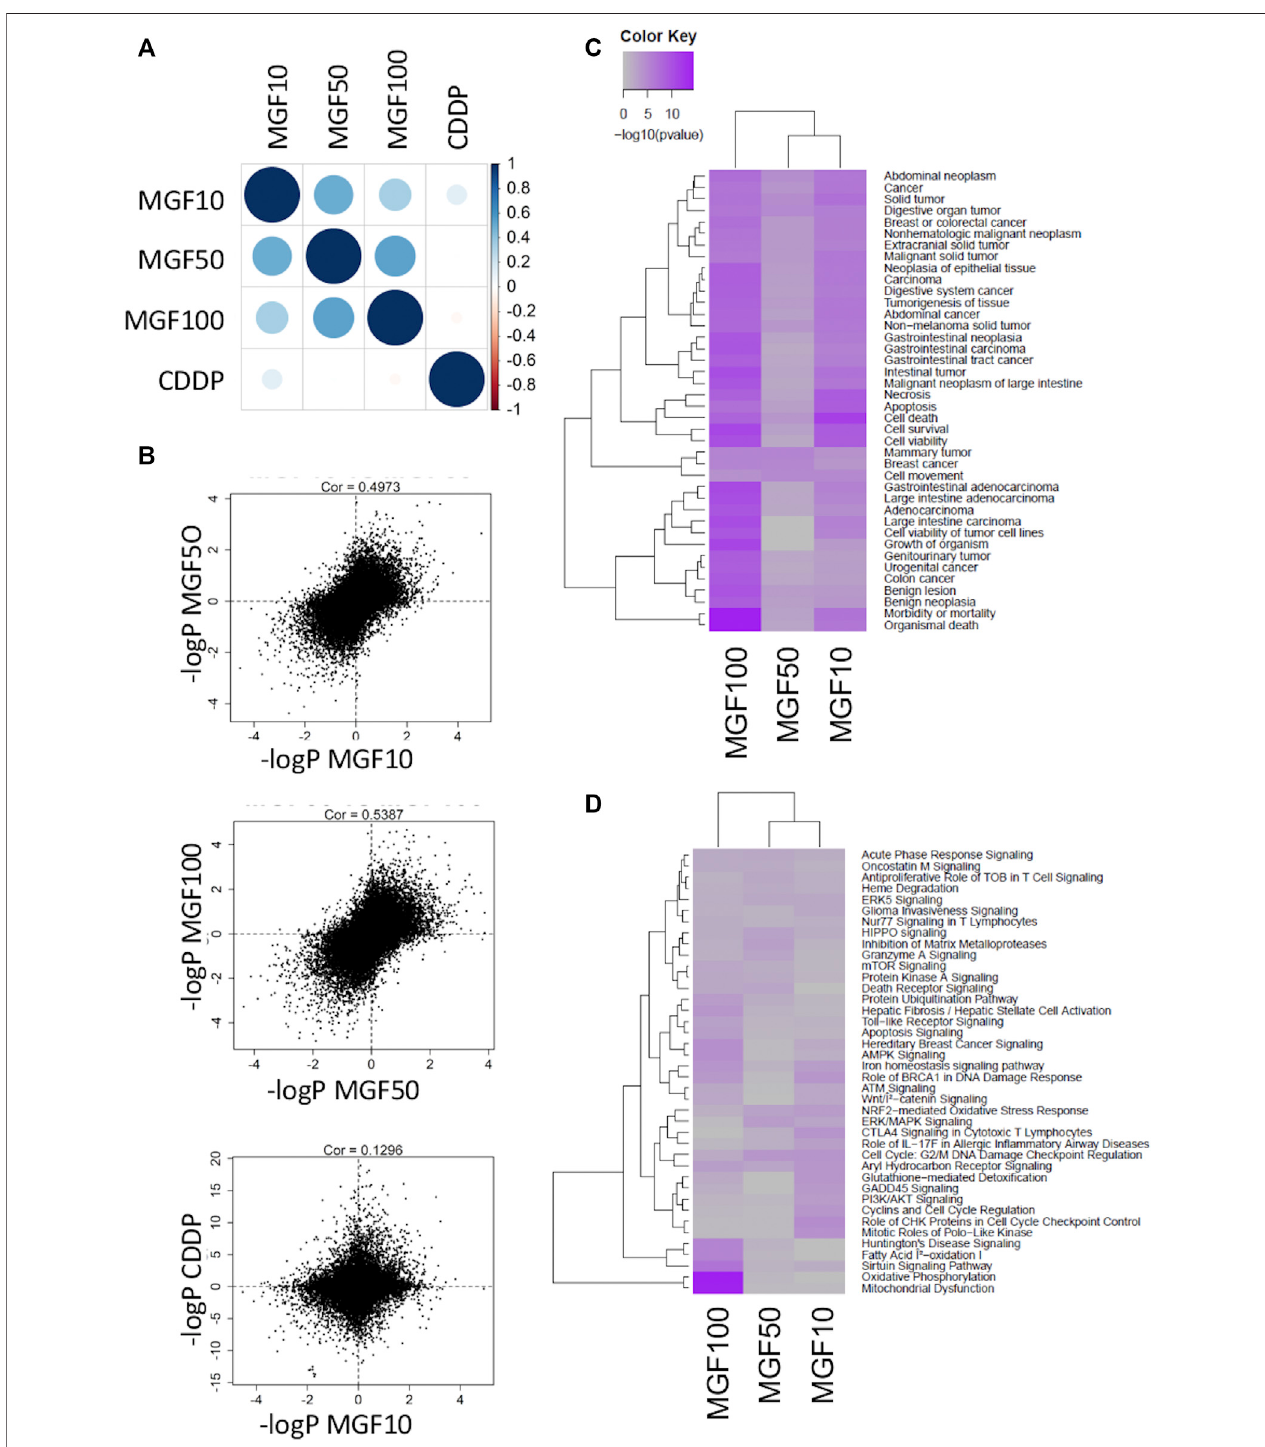
FIGURE 2 | MGF treatment of CT26. WT colorectal cancer model reshapes gene expression patterns controlling cell death, cell growth, cell motility and mitochondrial disease functions. (A) Cross-comparison of common transcriptional changes of the different treatments by correlating the -log10 p-values for every treatment combination. (B) Scatter plot pearson correlations of transcriptional gene responses for different MGF doses and for MGF versus CDDP treatments (C) IPA pathway enrichment analysis of disease functions. (D) IPA pathway enrichment analysis of biological pathways.